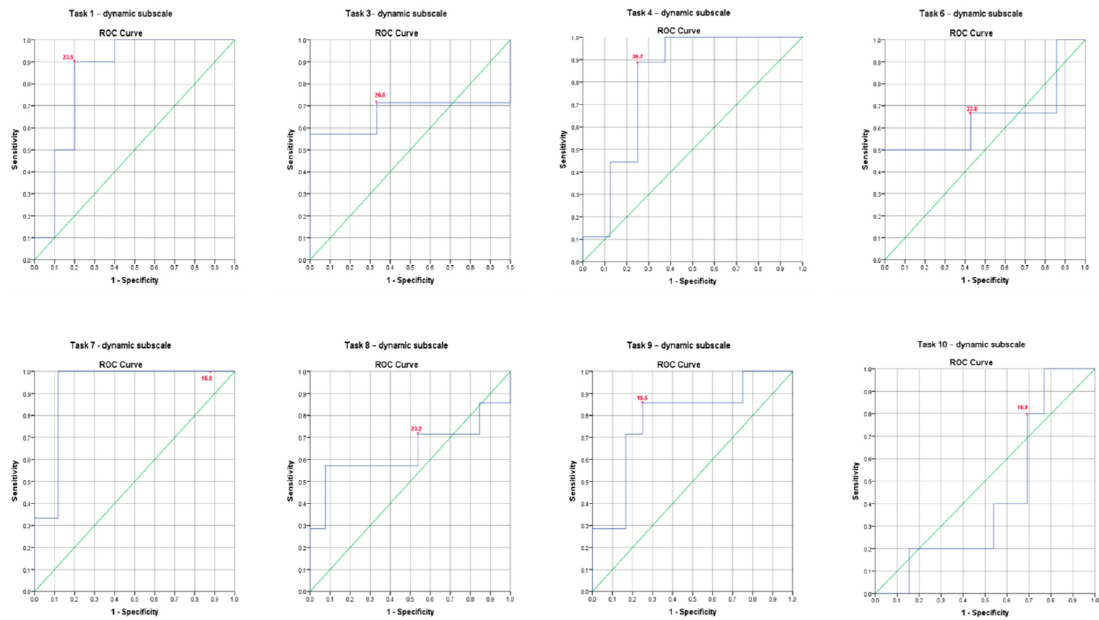
Figure 2. Receiver operator curves (ROC) of the iTIS dynamic subscale parameters to distinguish between stroke participants with impairment (scored zero on cTIS-V2 tasks) and those without trunk impairment (scored one, or two on cTIS-V2 tasks). * indicates cut-o ff